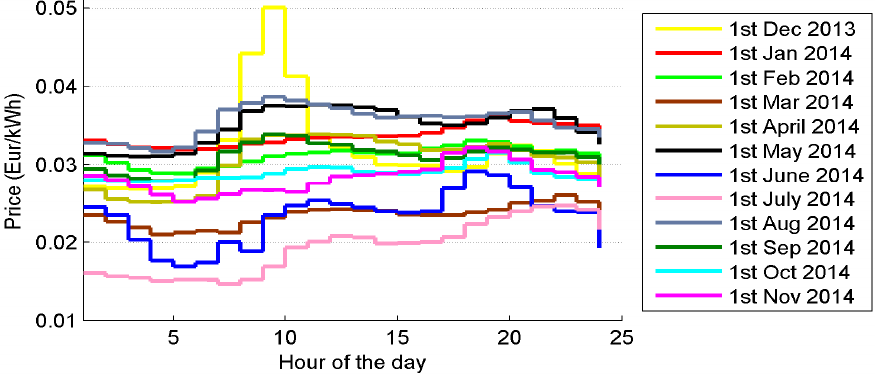
Figure 3. Example of the hourly pricing of electricity used in the simulation, showing the plot for 1st day of every month from December 2013 to November 2014 [28]. Table 1. Data specification of the appliance scheduling.